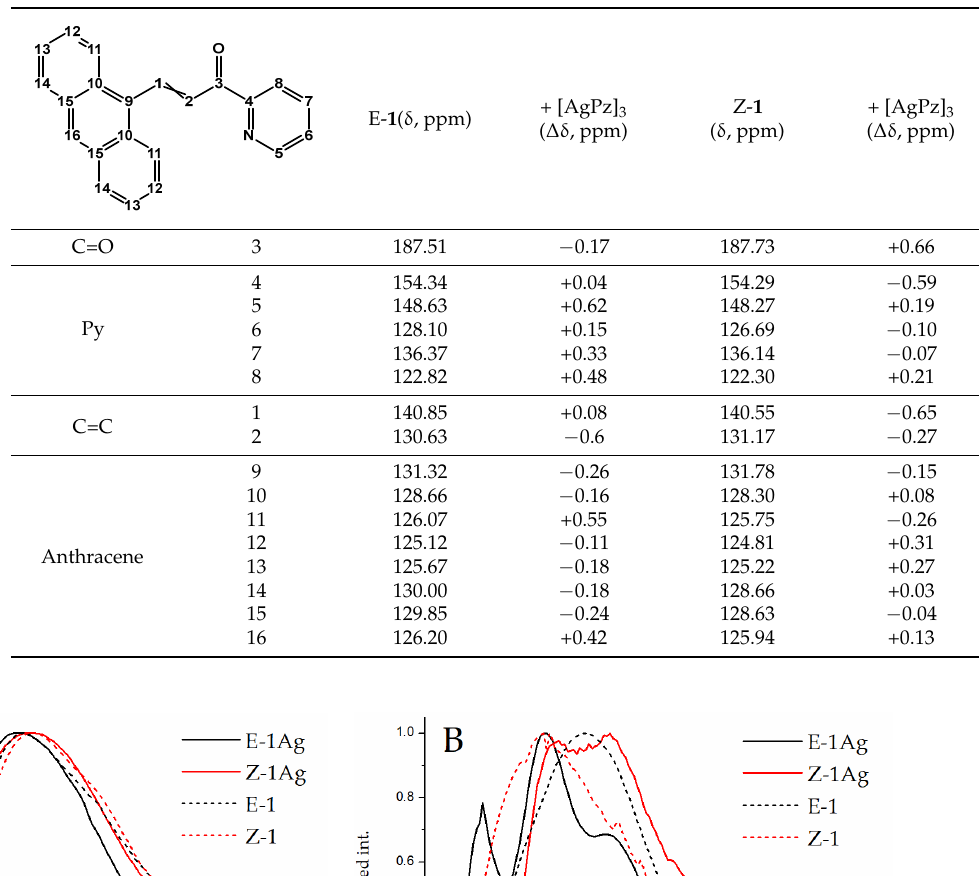
7 of 13 Figure 6. The IR spectra of chalcones Z- 1 , (c = 0.015 M, d = 1 mm, black line) in the presence of 0.5 (red), 1 (green), and 2 (blue) equivalents of [AgPz] 3 ; CCl 4 , 298 K. * δ (C-N) [AgPz]3. The interaction of Z- 1 with [AgPz] 3 is also accompanied by the changing of color. The initial orange solution of Z- 1 became red-orange upon the addition of the macrocy- cle. The crystallization from the saturated solution of chalcone Z- 1 with macrocycle [AgPz] 3 , an equimolar reagents ratio, leads to the formation of previously described complex Z-1Ag , which was obtained by the crystallization of chalcone 1 (E-isomer) under the light. Investigation of the [AgPz] 3 interactions with Z-1 and E-1 in the solution was carried out using 1 H and 13 C NMR spectroscopy in CCl 4 /C 6 D 6 mixture ( v / v =9/1) (Figures S1–S8). The resonances of all protons in Z -1 and E -1 undergo a high- fi eld shift in the presence of the macrocycle. The main di ff erences have been observed in the 13 C NMR spectra. The carbonyl group carbon atom resonance of E- 1 does not possess any changes upon the addition of [AgPz] 3 . In contrast, the peak for the carbon atom of the CO group Z- 1 un- dergoes a low- fi eld shift by 0.66 ppm upon adding even a 0.5 equivalent of silver mac- rocycle at room temperature. The resonances of carbon atoms (numbers 4–8 in Table 2) in the pyridine fragment of E- 1 undergo only a low- fi eld shift. The resonances of C4 and C6-7 in the pyridine fragment of chalcone Z- 1 show the high- fi eld shifts demonstrating the participation of this fragment in coordination. Carbon atoms in anthracenyl frag-